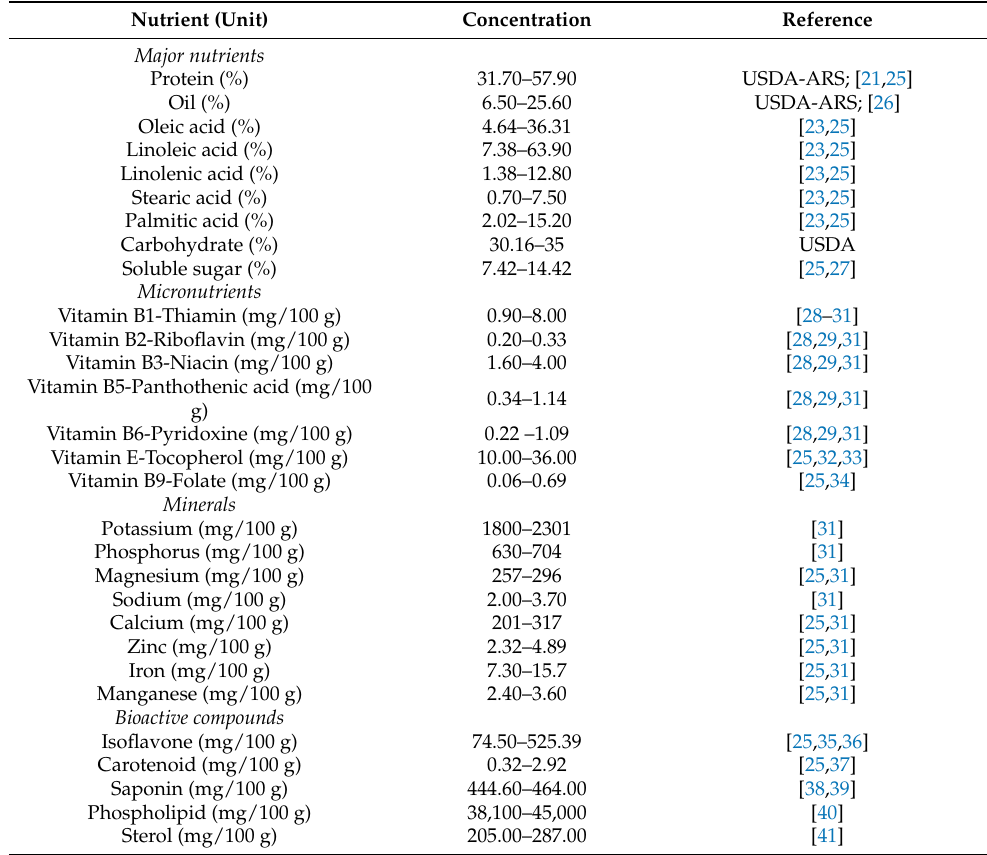
essential fatty acids, including omega-3 fatty acid, α -linolenic acid and omega-6 fatty acid linoleic acid. Compared to most crops and legumes, soybeans are relatively low in carbohy- drates, with a very low glycaemic index, and are a rich source of micronutrients, including vitamins and minerals (Table 1). Soybean is a good source of folate, with levels typically ranging from 64.51–691.24 µ g/100 g (Table 1). This is significantly higher than other crops (Table 2), making soybean a valuable source of this micronutrient. Soybean is also the richest source of isoflavones, with concentrations ranging from 74.50–525.39 mg/100 g (Table 1). Additionally, the soybean seed contains other phytochemicals, including saponin, lunasin, and sterols [24], making it a potential source of essential nutrients and nutraceuticals with implications for human health. Table 1. The nutritional profile of the soybean seed.